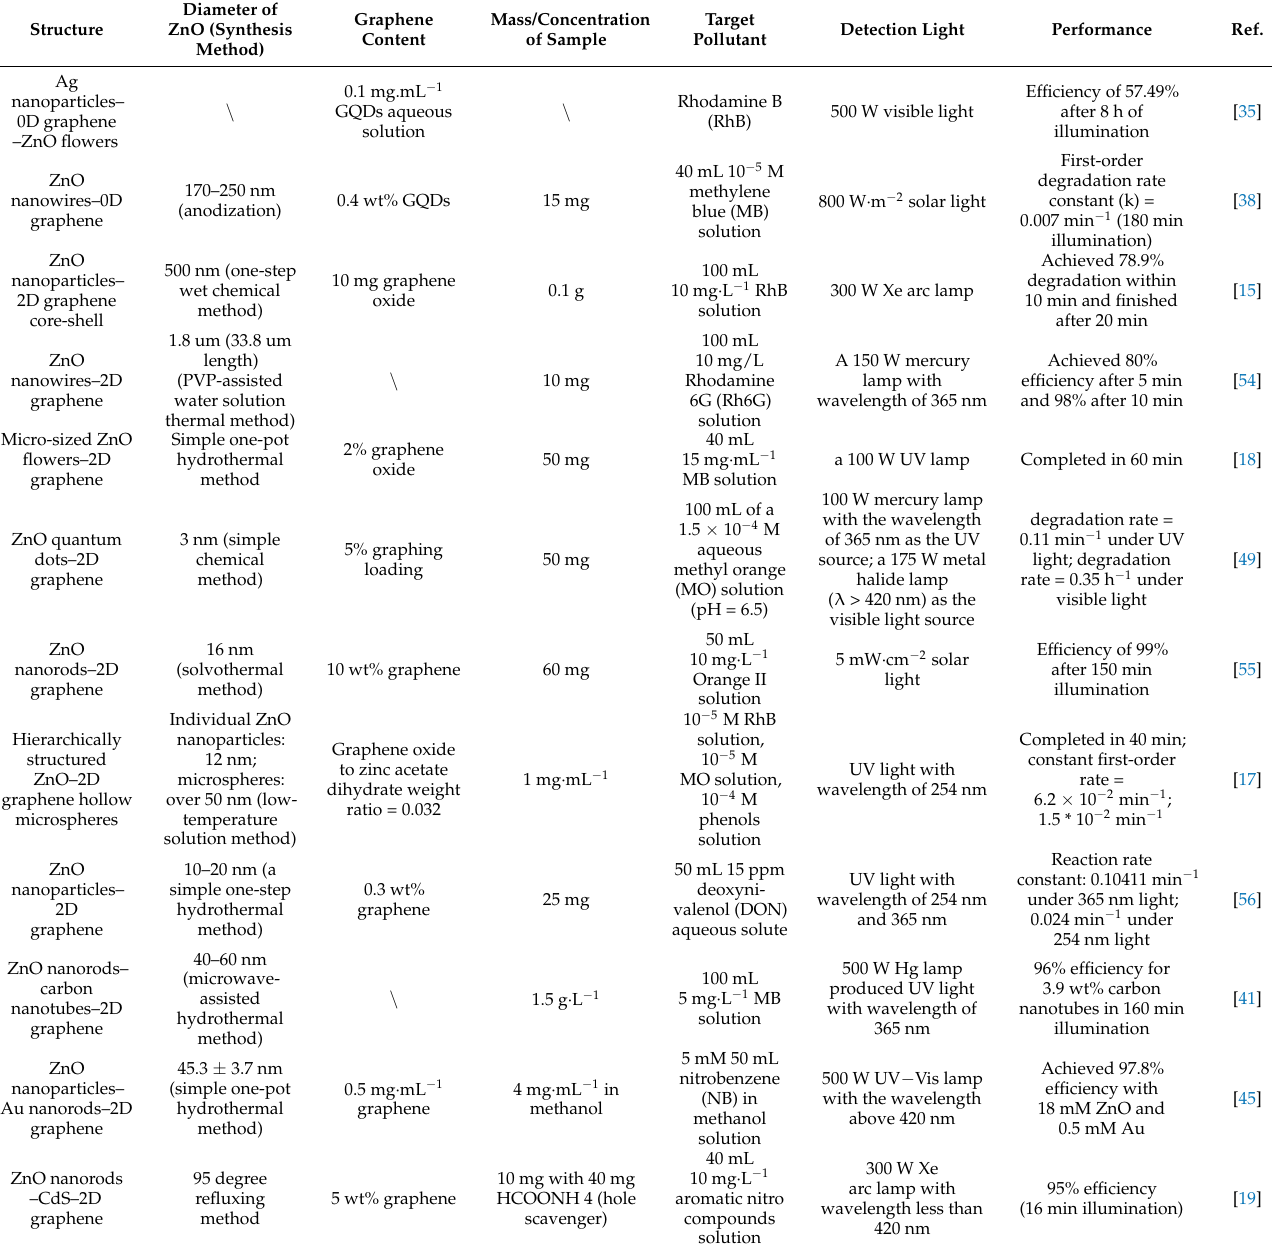
MB. K is the first-order degradation rate constant. Table 1. Physical properties information and performance statistics of ZnO–graphene materials with various structures.